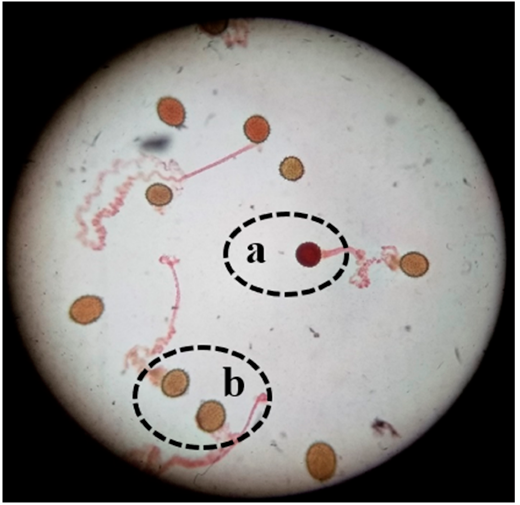
Figure 2. An example of results from the triphenyl-tetrazolium chloride (TTC) test. Viable pollen has changed to a red color (labeled as ‘a’) while non-viable pollen does not change color (labeled as ‘b’). Table 2. Top and bottom canopy temperature in 13 cotton genotypes grown under field conditions in 2019 in Faisalabad,